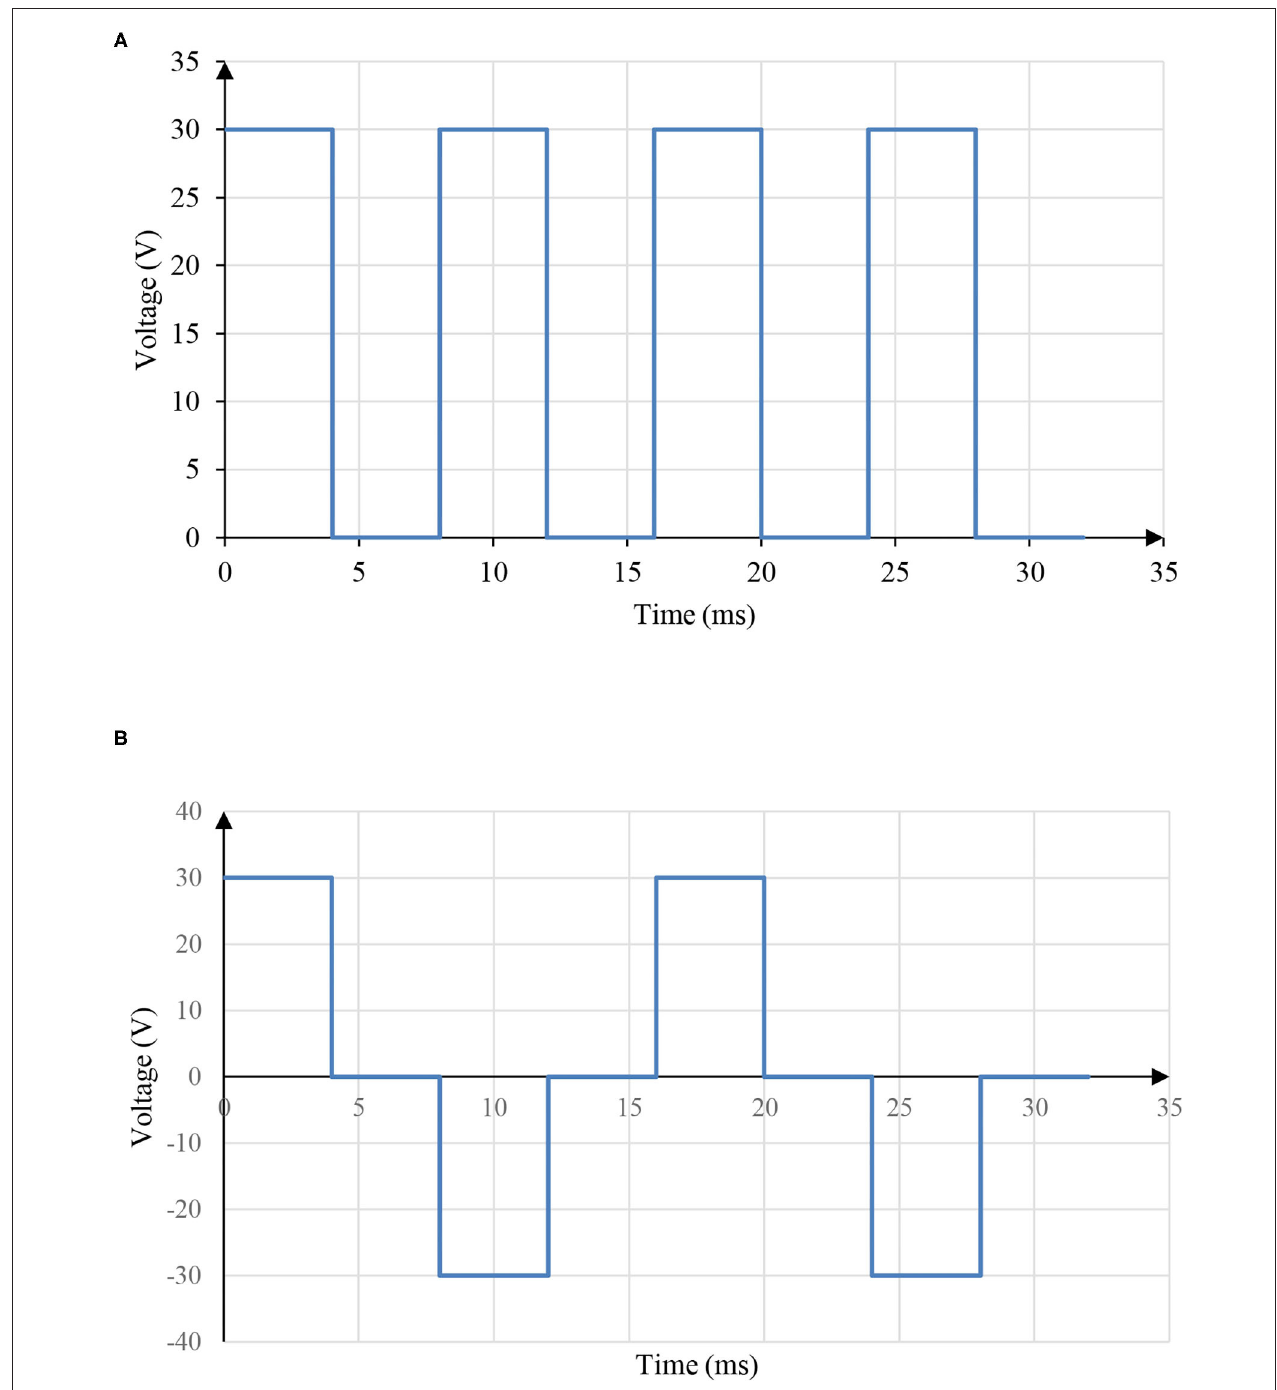
FIGURE 5 | Square waves in DC driving scheme and AC driving scheme. (A) The square wave in DC driving scheme. (B) The square wave in AC driving scheme.